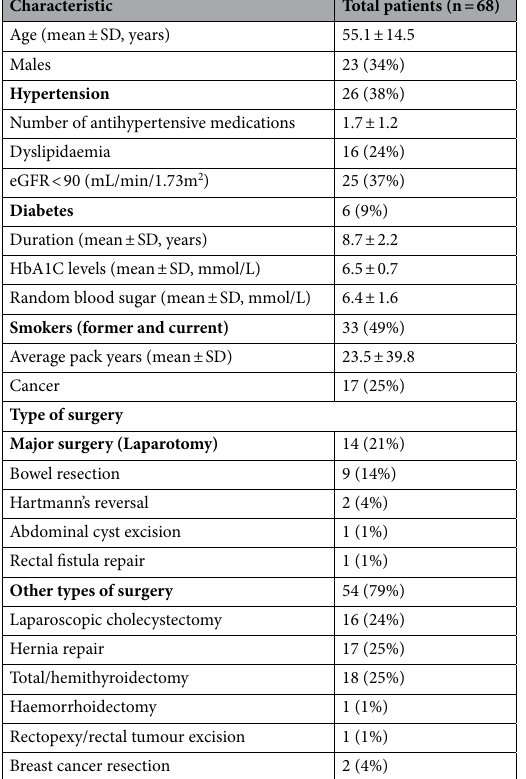
Table 1. Participant characteristics.